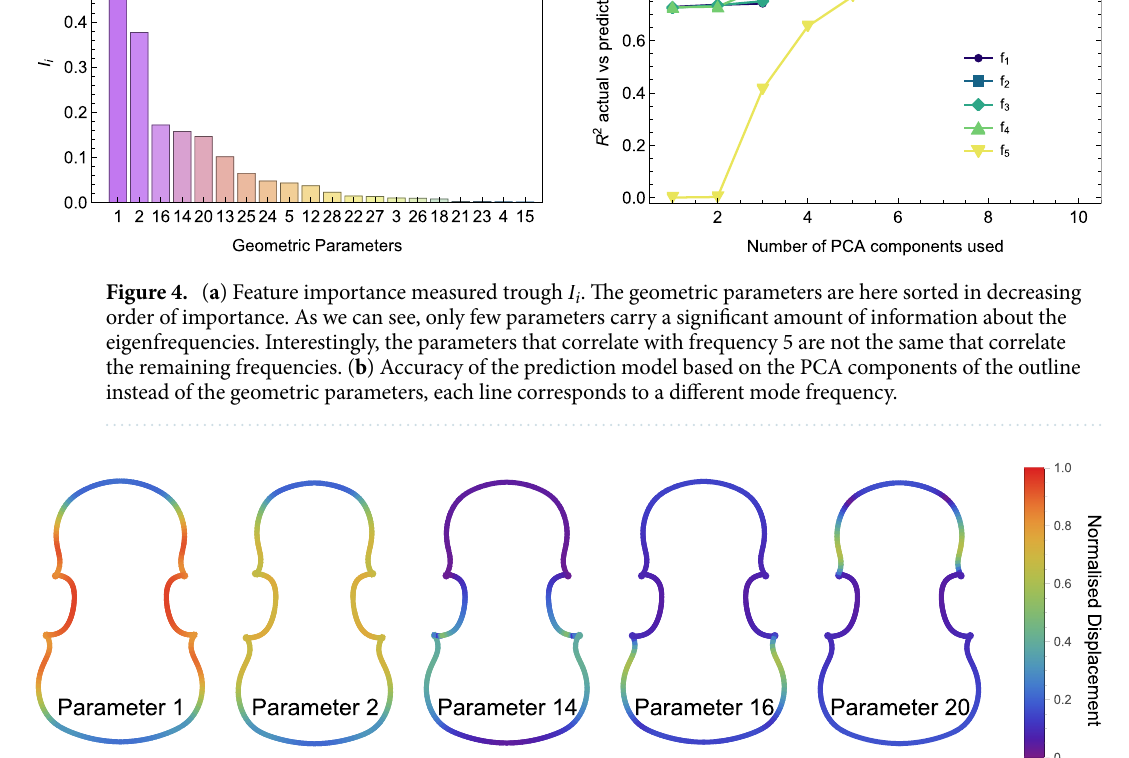
Figure 5. Outline change for a 5% variation of the for the first 5 parameters of the model, ordered by relevance from Fig. 4. The colour code represents the displacement of each point of the outline, normalised by the maximum displacement, from the average